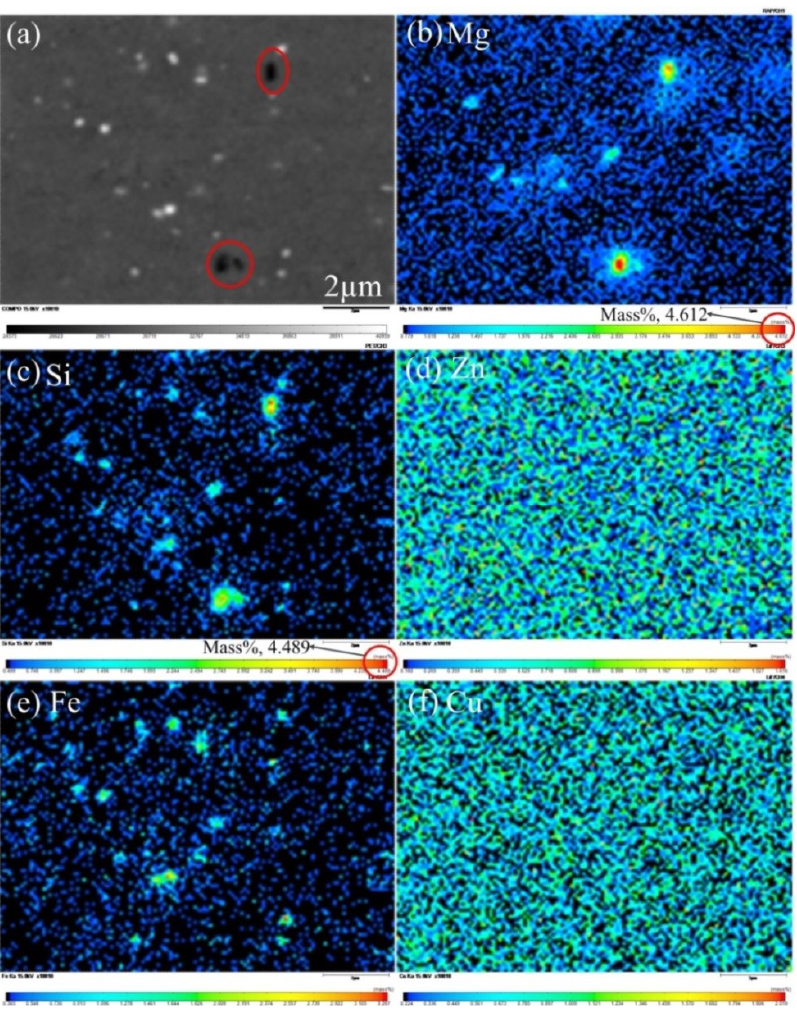
Figure 6. Element map of local area in Figure 5: ( a ) the local area; the element content of ( b ) Mg, ( c ) Si, ( d ) Zn, ( e ) Fe and ( f ) Cu.